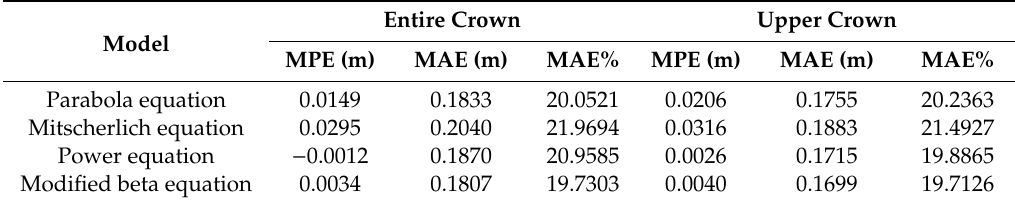
Table 5. Validation results for the four crown profile models.